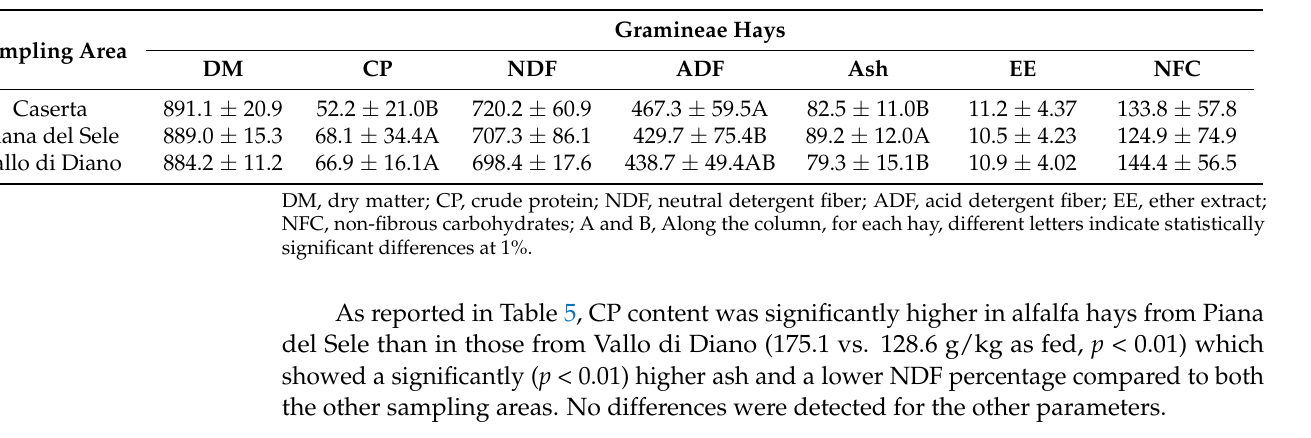
Table 4. Chemical composition (g/kg as fed; mean ± SD) of Gramineae hays according to the sampling area.